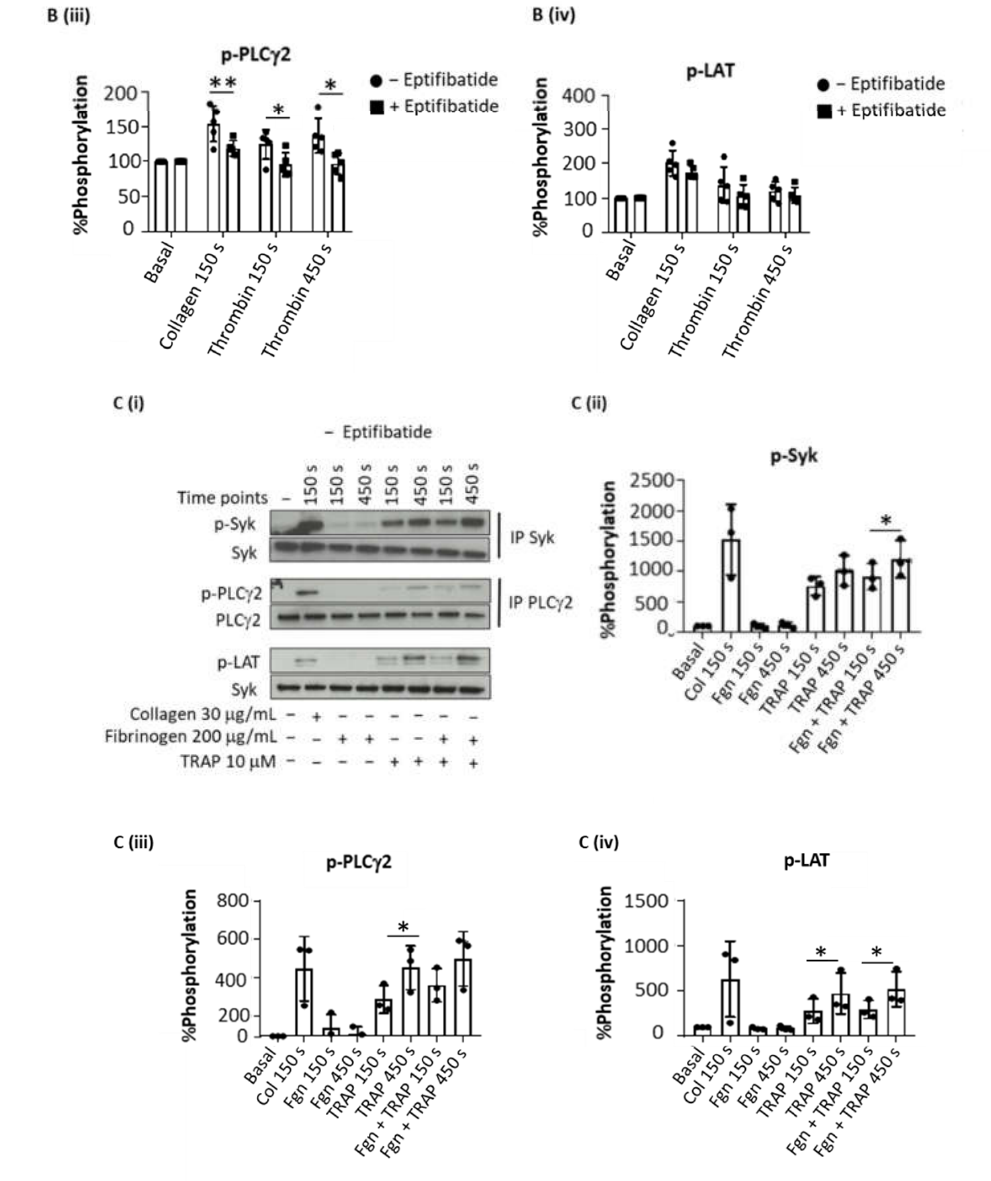
Figure 1. Sustained Syk phosphorylation in thrombin-stimulated platelet is integrin-dependent. Washed platelets at 5 × 10 8 /mL were stimulated with Horm collagen (30 µ g/mL), thrombin (1 U/mL), TRAP (10 µ M) or fibrinogen (200 µ g/mL) in the presence or absence of eptifibatide (9 µ M). Activation was stopped at stated time after addition of the agonist. ( A ) Representative blot of Syk tyrosine phosphorylation from 6 donors. ( Ai ) Whole cell lysates were immunoprecipitated with anti-Syk mAb and probed with anti-phospho-tyrosine mAb 4G10; ( Aii ) Percentage of Syk tyrosine phosphorylation, based on Western blots, from 6 donors (mean ± s.d.); ( Aiii ) Aggregation trace of platelets stimulated with thrombin (1 U/mL), representative of 3 donors, and ( Aiv ) graph showing aggregation as % light transmission (mean ± s.d.) after 50 min of agonist stimulation. ( B ) Representative Western blot ( Bi ), and calculated percentage of Syk ( Bii ), PLC γ 2 ( Biii ) and LAT ( Biv ) phosphorylation in response to thrombin (Thromb) from 5 donors (mean ± s.d.). Horm collagen (Col) was used as positive control. ( C ) Representative blot ( Ci ); mean ± s.d. of Syk ( Cii ), PLC γ 2 ( Ciii ) and LAT ( Civ ) phosphorylation in response to collagen (Col), TRAP or fibrinogen (Fgn) from 3 donors. * p < 0.05, ** p < 0.005, one-tailed paired Student’s t -test. Where stated, proteins were immunoprecipitated (IP).